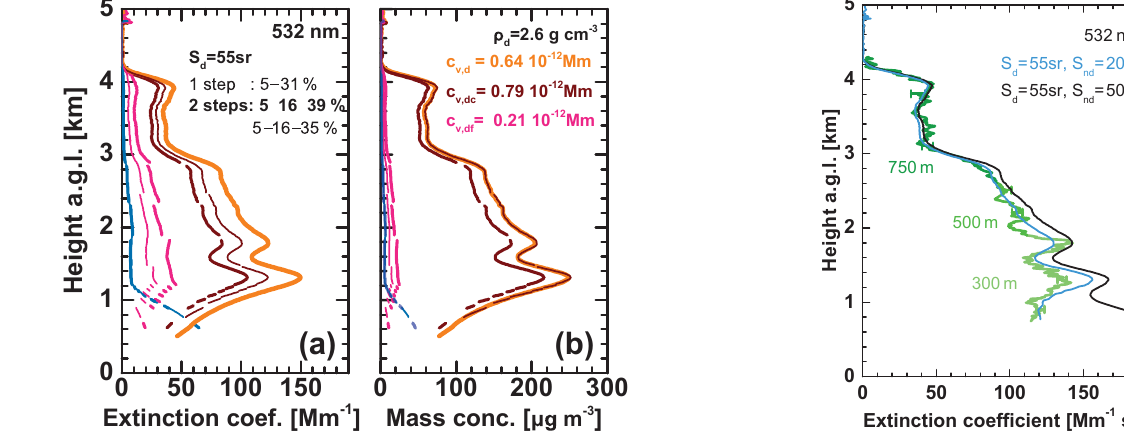
Figure 11. (a) Comparison of fine (pink) and coarse (dark red) dust extinction profiles (532nm) obtained with the two-step method for two dust scenarios (scenario 1: thick lines, BFMF = 0.33, de- polarization ratio combination 5–16–39%; scenario 2: thin lines, BFMF = 0.2, depolarization ratio combination 5–16–35%). (b) Re- spective mass concentrations, calculated from the extinction coeffi- cients in (a) . The same data analysis (combined use of the one-step and two-step method) as illustrated in Fig. 10 is applied here. The lidar ratio of 55sr is applied to all (total, fine, coarse) backscatter coefficients to obtain the shown extinction profiles. The blue lines indicate the marine (non-dust) extinction and mass concentration profiles.